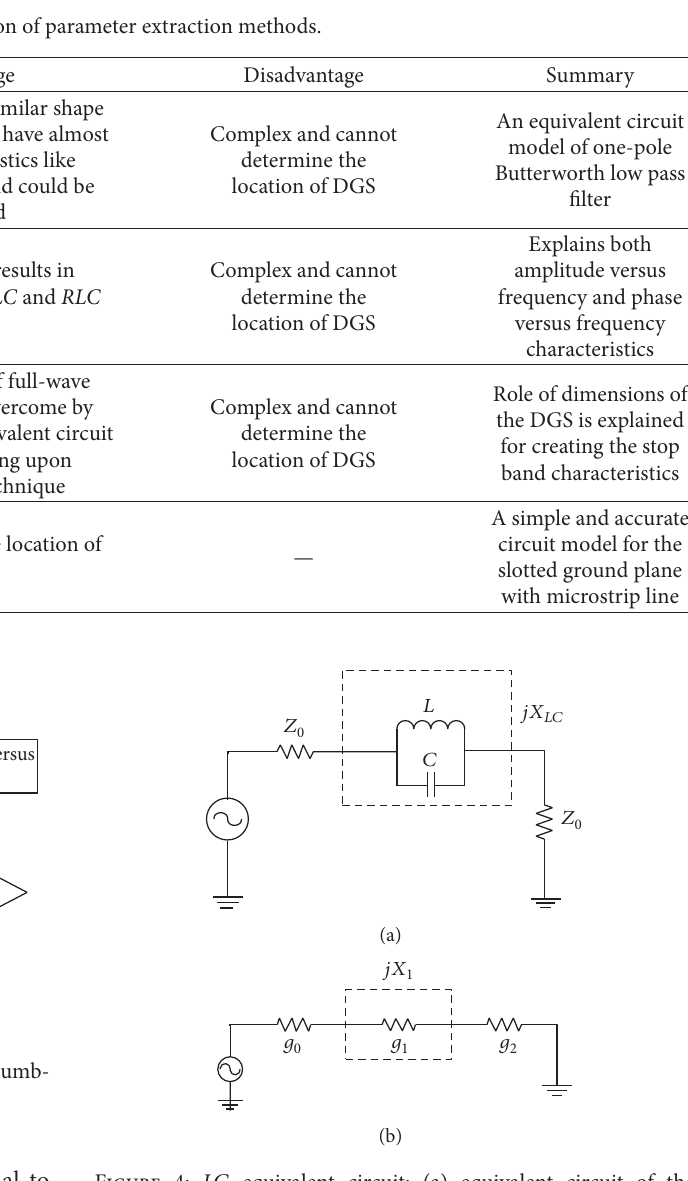
Figure 4: 𝐿𝐶 equivalent circuit: (a) equivalent circuit of the dumbbell DGS circuit; (b)Butterworth-typeone-poleprototypelow pass filter circuit